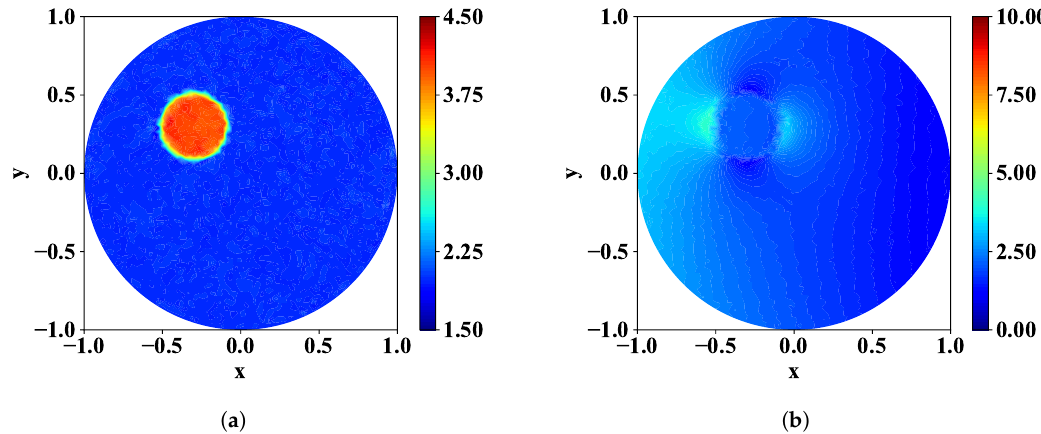
Figure 8. When SNR = 40 dB, σ = 4.0S/m and the step is 11: ( a ) the reconstructed image and ( b ) the power